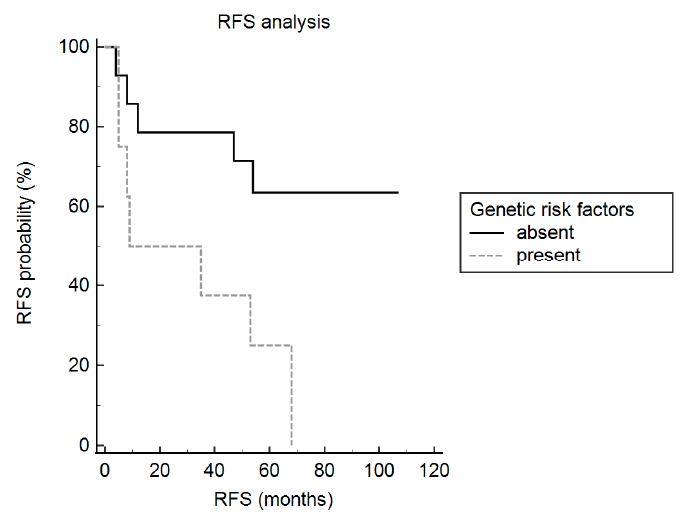
Figure 3. Impact of genetic risk factors on clinical outcome. RFS analysis showed that the presence of 18q heterozygous deletion or CDKN2A/B homozygous deletion is associated with worse prognosis in atypical meningiomas ( p = 0.008).